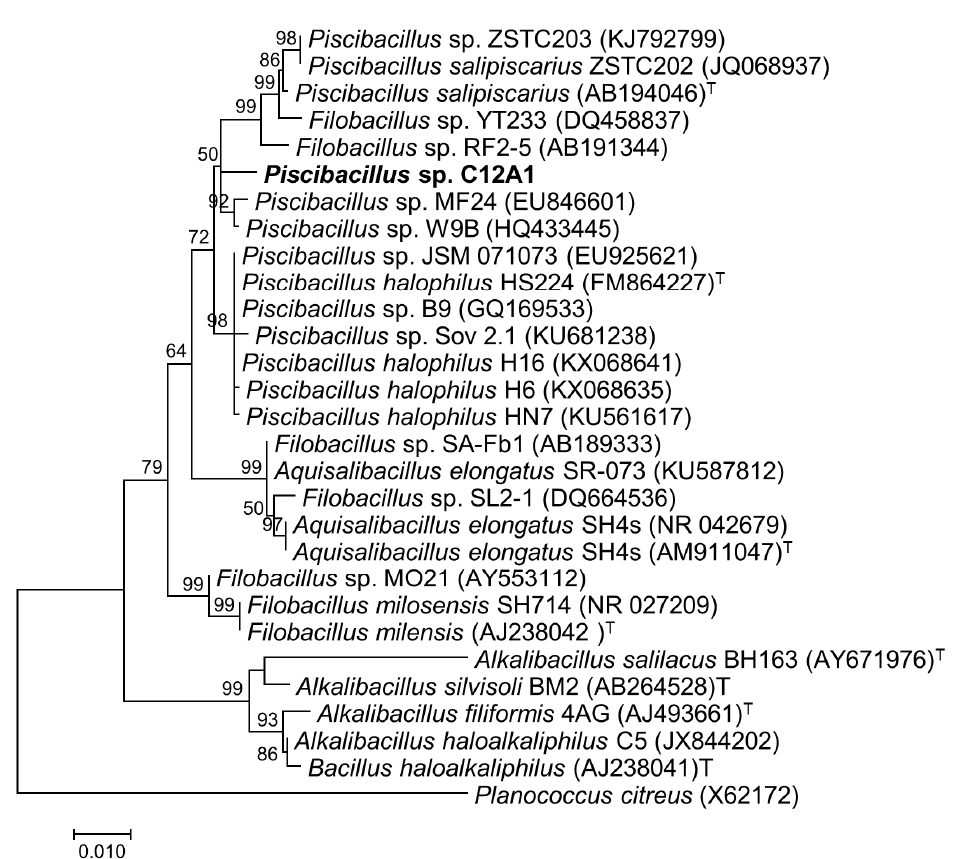
Figure 3. UV-visible spectrum of yellow pigment extracted in methanol showing carotenoids peaks Microorganisms 2018 , 6 , x FOR PEER REVIEW at 428 nm, 450 nm, and 480 nm. 3.4. Phylogenetic Analysis. 428 nm, 450 nm, and 480 nm.